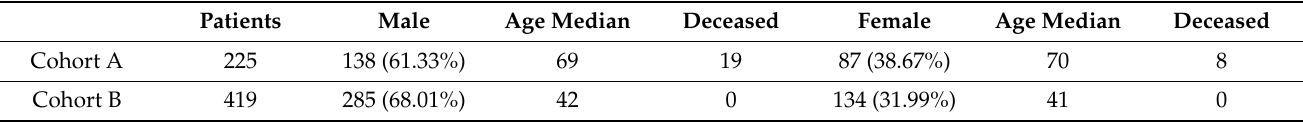
Table 1. Basic demographic data.